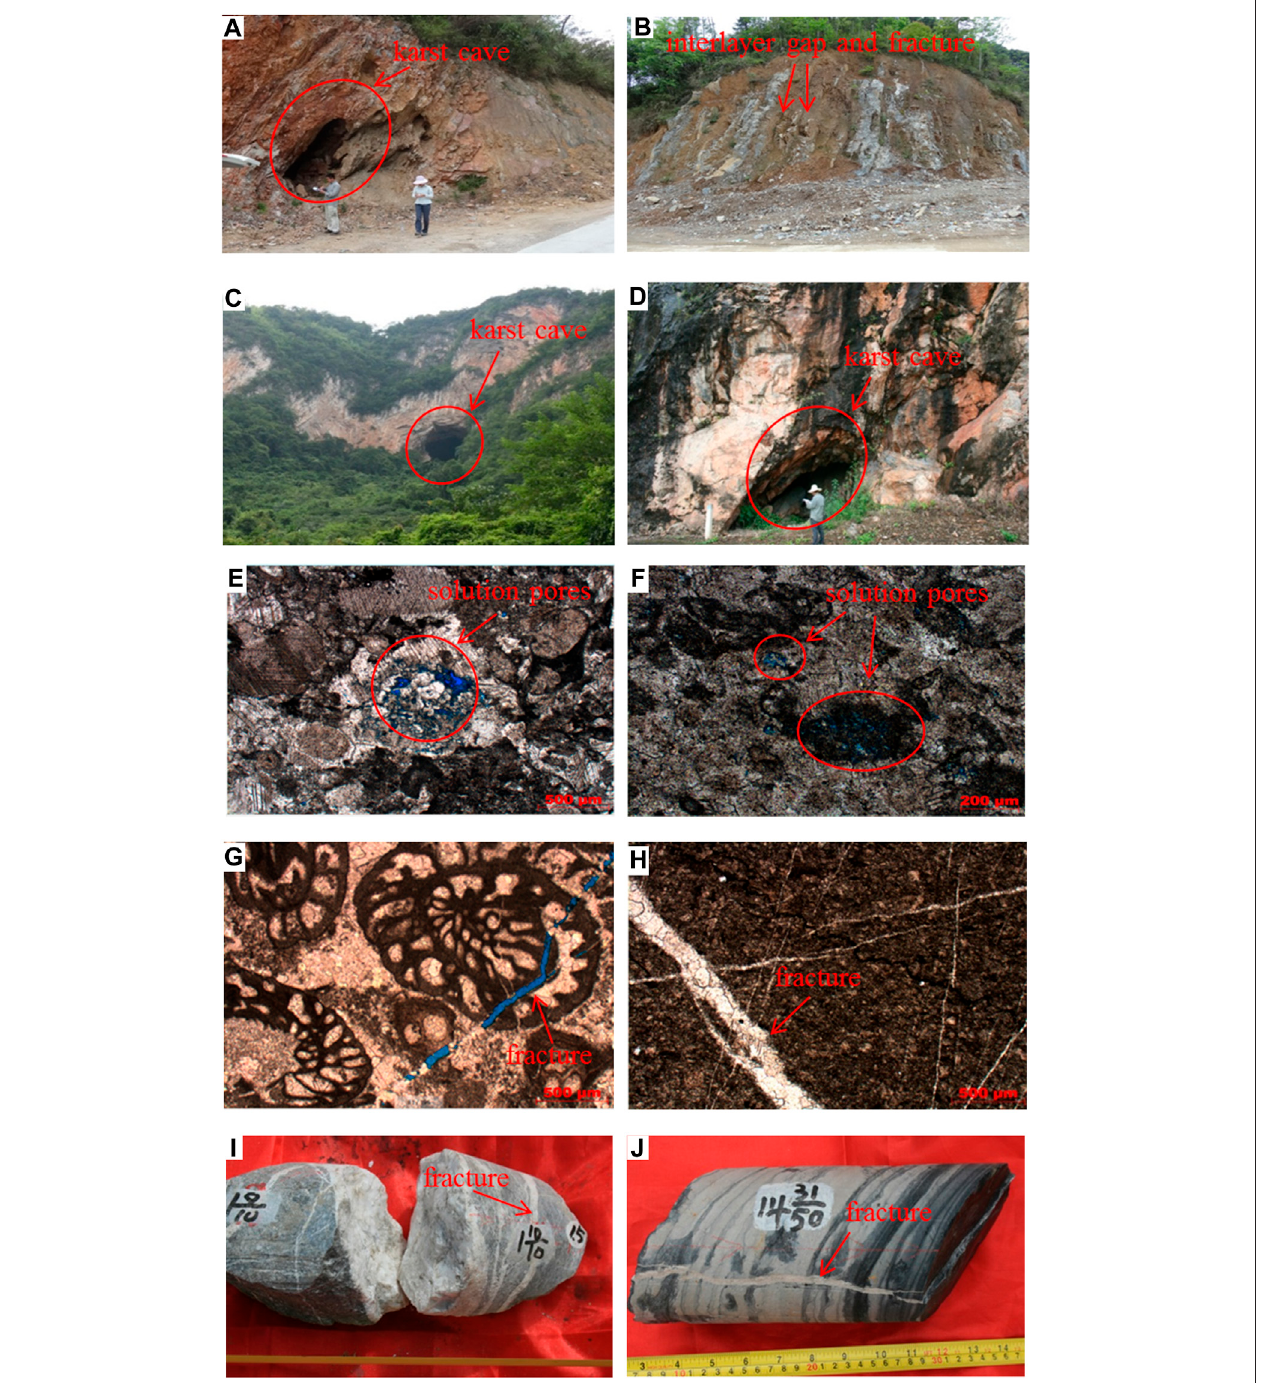
FIGURE 7 | Reservoir space types of different karst formations. (A) Karst caves are developed in CP n 2 (Fengting section in Luodian). (B) Marl of the Wuzhishan Formation. Reservoir spaceis the interlayer gap and fracture (Fengting section in Luodian). (C) Karst caves are developed in CP n 2 (Luotuo section in Luodian). (D) Karst cavesaredeveloped inCP n 2 (MengjiangBridgeinLuodian). (E) LimestonewithsolutionporesofCP n 2 (FengtingsectioninLuodian).(F)Limestonewithsolutionporesof the Sidazhai Formation (Fengting section in Luodian). (G) Limestone of CP n 2 , fracture growing (Fengting section in Luodian). (H) Limestone of CP n 2 , fracture growing (Fengting section in Luodian). (I) ZY1 limestone of CP n 2 , fracture growing (well ZY1); (J) . Marl of the Wuzhishan Formation, fracture growing (well ZY1))